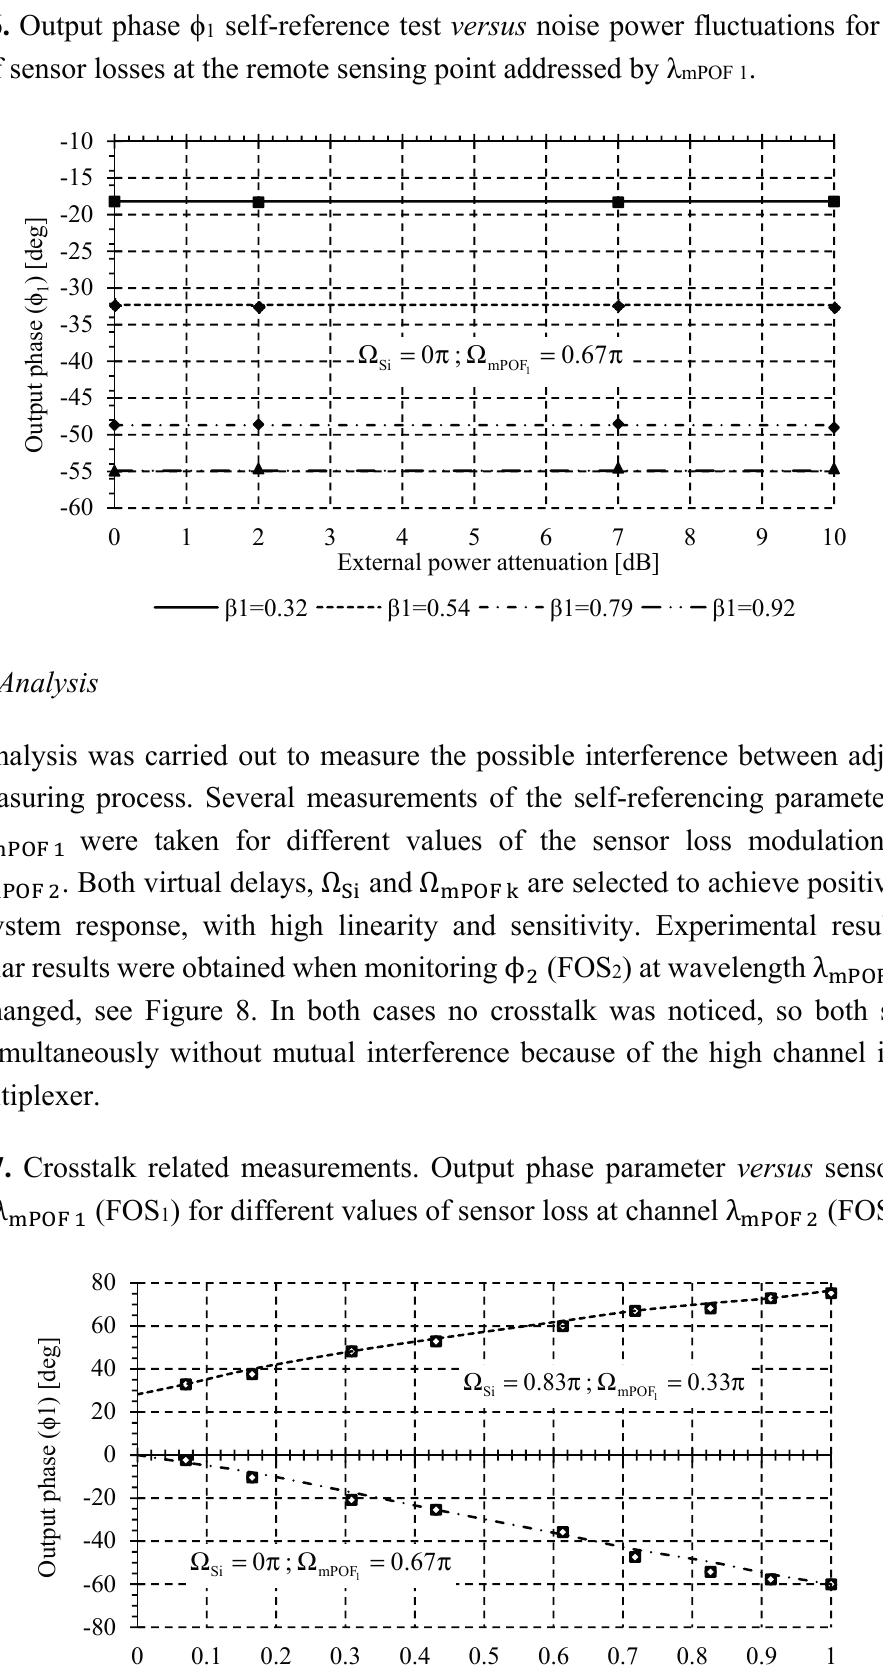
(FOS 2 (cid:2923)(cid:2900)(cid:2899)(cid:2890) (cid:2870)